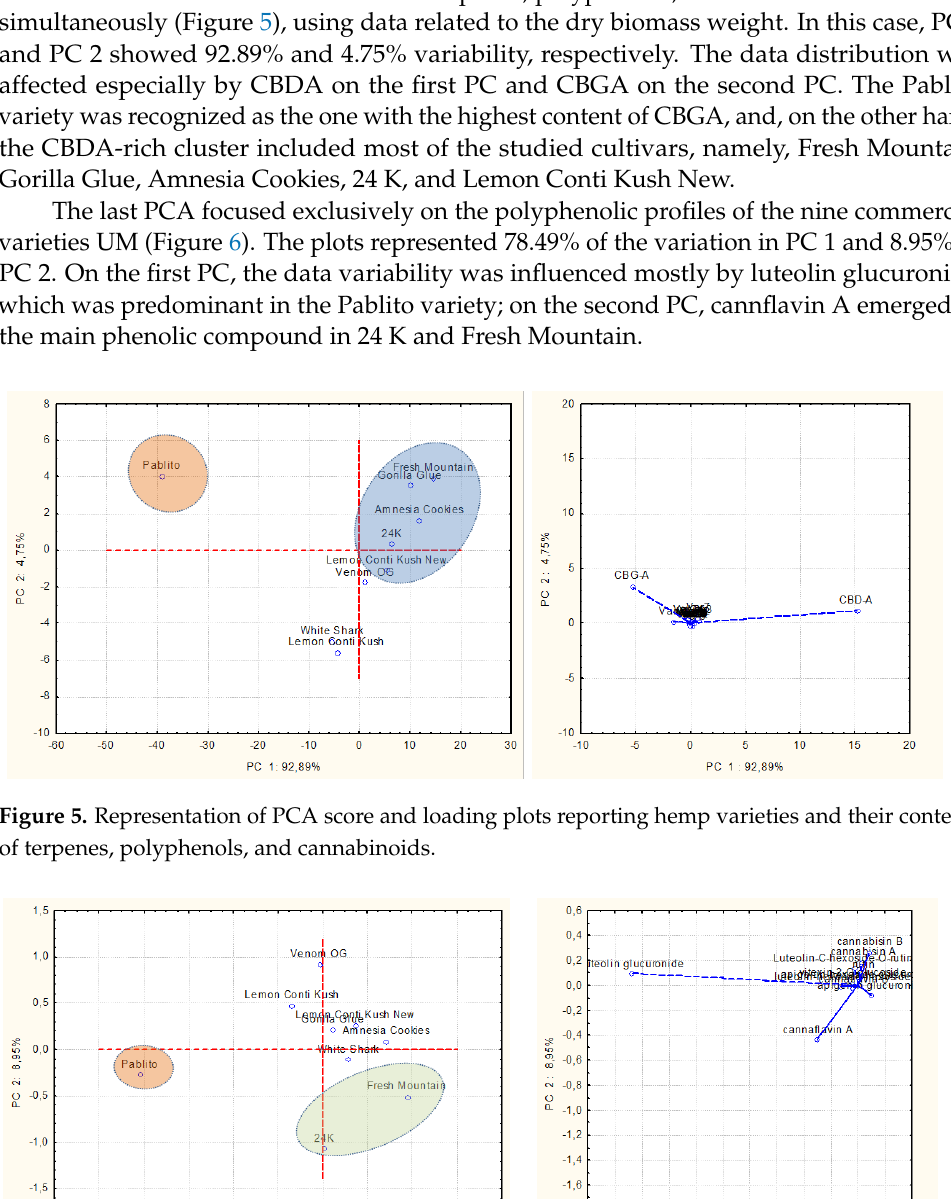
Figure 6. Representation of PCA score and loading plots reporting hemp varieties and the main polyphenols in UM.